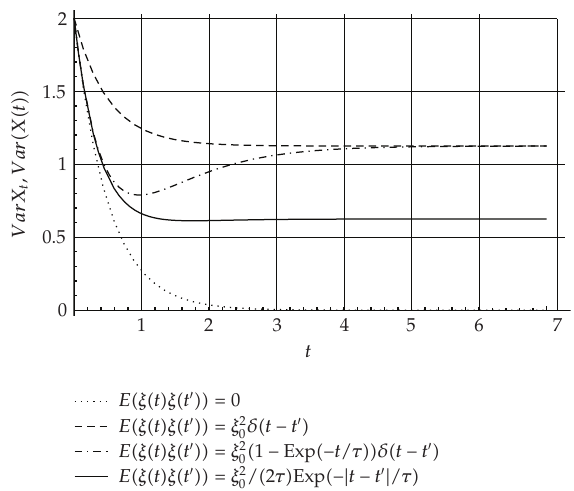
Figure 1: The variances as a function of time assuming linear friction. Var (cid:2) X (cid:2) 0 (cid:3)(cid:3) (cid:10) 2 ,a (cid:10) 1 ,ξ 0 (cid:10) 1 . 5 ,τ (cid:10) 0 . 8 ,t 0 (cid:10) 0